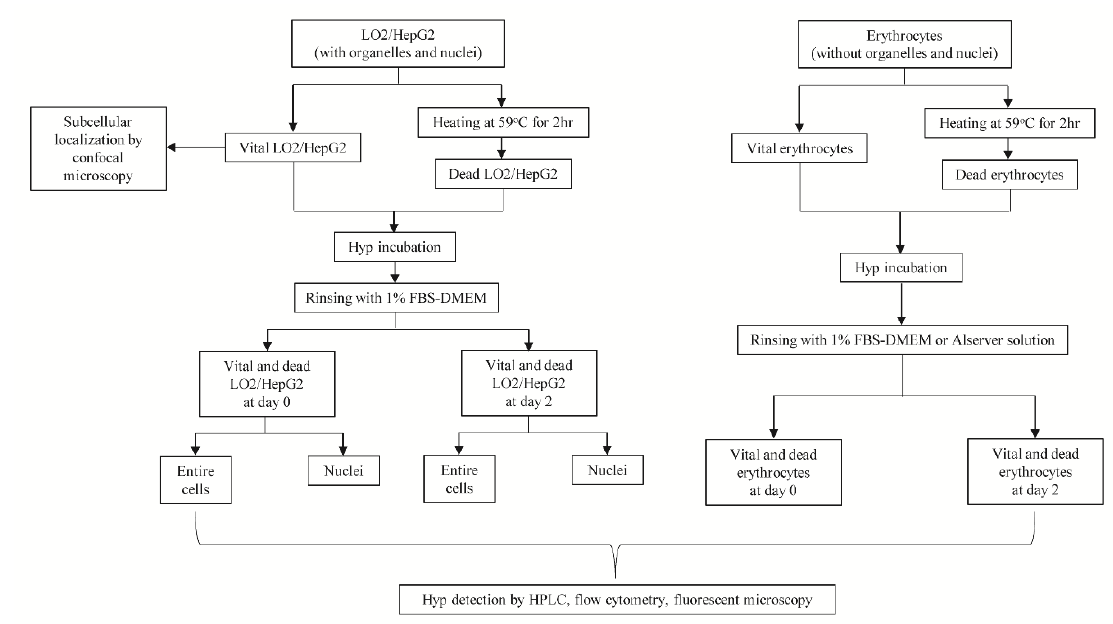
Figure 1. Flow diagram of protocols for the current in vitro study. Note: LO2 is a normal liver cell line, whereas HepG2 is a human-derived hepatocellular carcinoma cell line. FBS-DMEM is the Dulbecco’s Modified Eagle’s Medium mixed with fetal bovine serum.